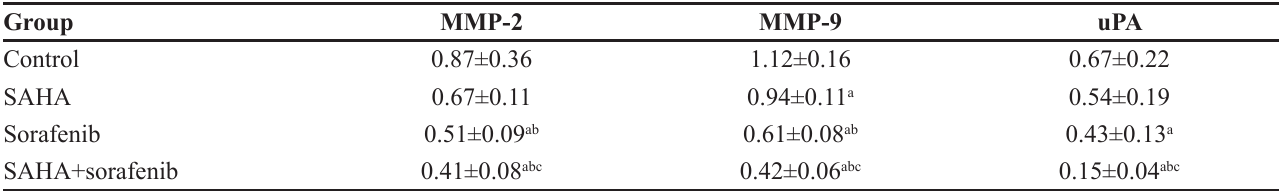
TABLE V - Expression of MMP-2 and MMP-9 and uPA protein in xenograft tissue (relative to β-actin)